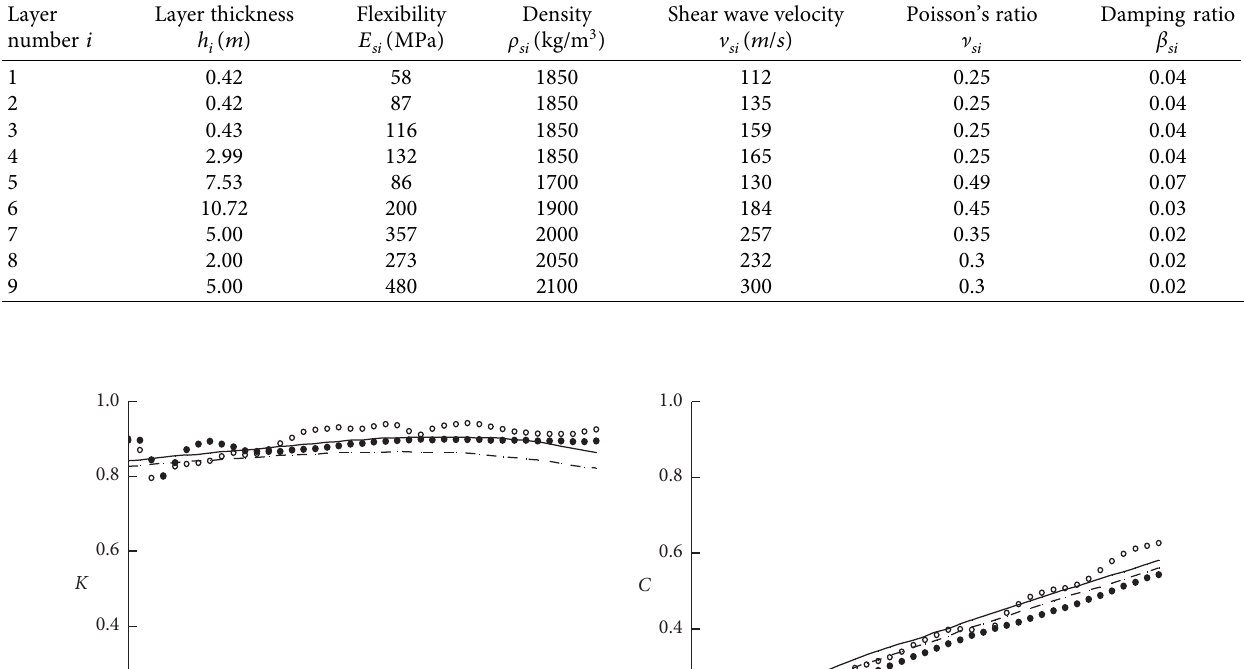
Table 1: Characteristic parameters of soil ground.